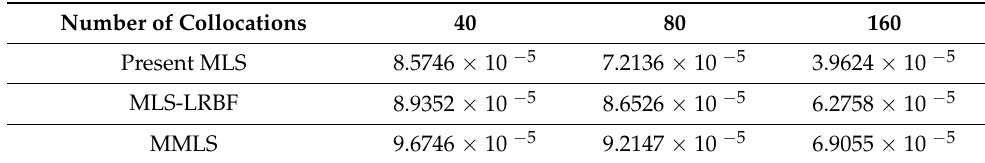
Table 1. The results of the root mean square error Rew with different numbers of collocation points (40, 80, 160).